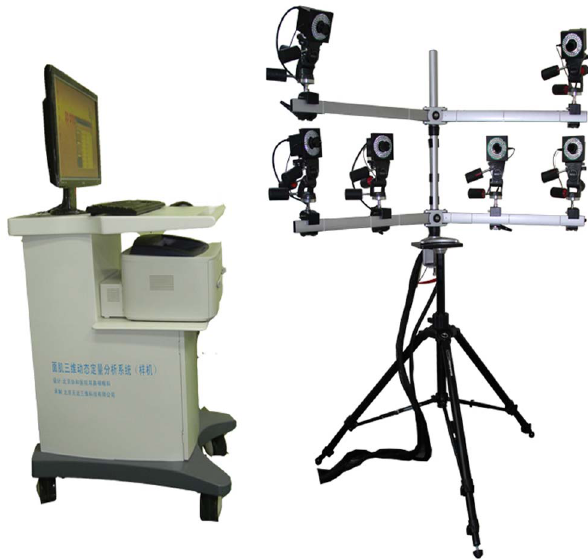
Figure 1. 3-Dimensional Dynamic Quantitative Analysis System of Facial Motion.